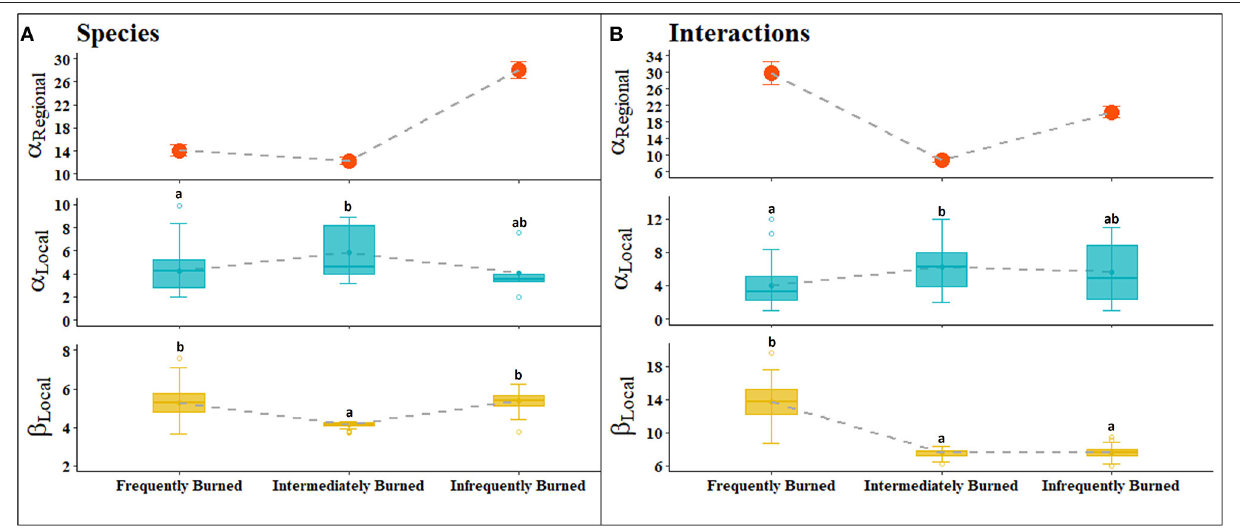
FIGURE 4 | (A) Species diversity components and (B) interaction diversity components calculated from frequently, intermediately, and infrequently burned sites at hierarchical spatial extents. The broader, regional-level alpha diversity (top panel) represents diversity calculated at each fire return interval category. Our use of the term regional does not infer a singular spatial aggregation, but rather a broader level organization. Local level alpha diversity (middle panel) and beta diversity (bottom panel) represent diversity components calculated at the plot level. Solid lines indicate median value and points connected to dashed lines indicate mean value within local level panels. Letters denote significant differences between local fire return interval categories based on Tukey’s test at P < 0.05. Diversity values are reported in